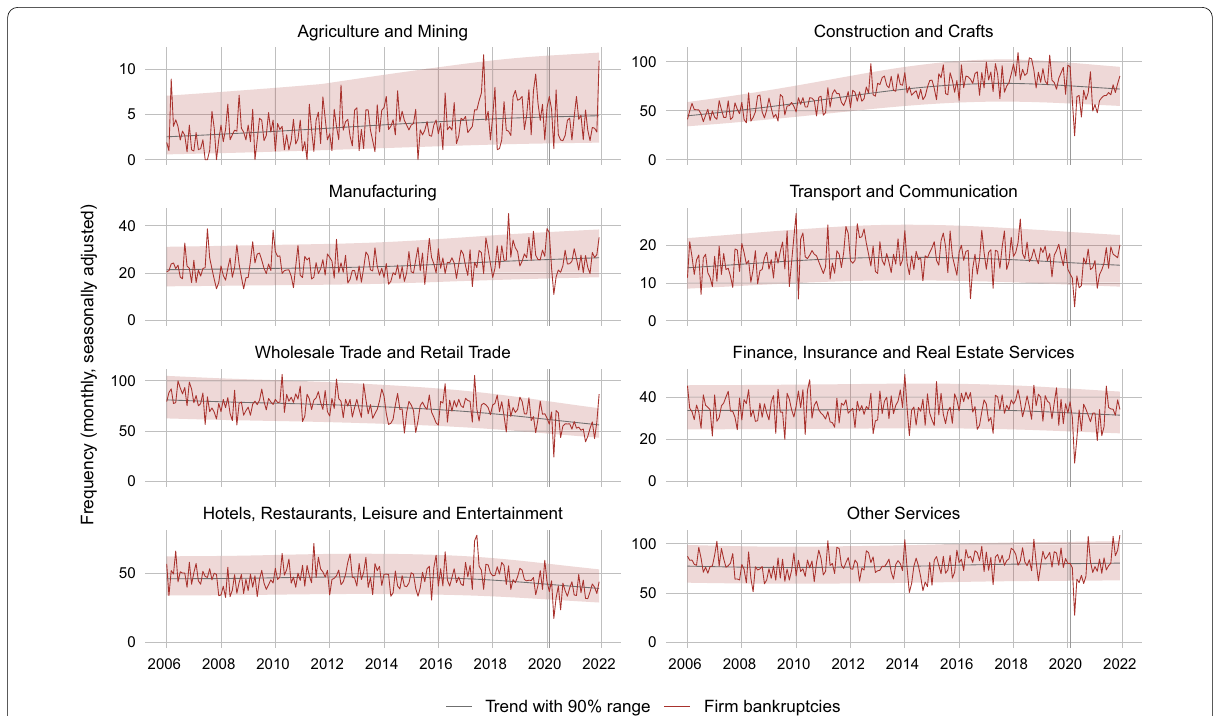
Fig. 5 Monthly frequency of firm bankruptcies at the industry level. Notes : The figure shows the monthly seasonally adjusted frequency of firm bankrupcties in different sectors of the Swiss economy excluding SCO Art. 731b cases, together with a trend and the 90% probability range. Industries are grouped together according to economic similarity. The vertical line marks the last month before the start of the COVID-19